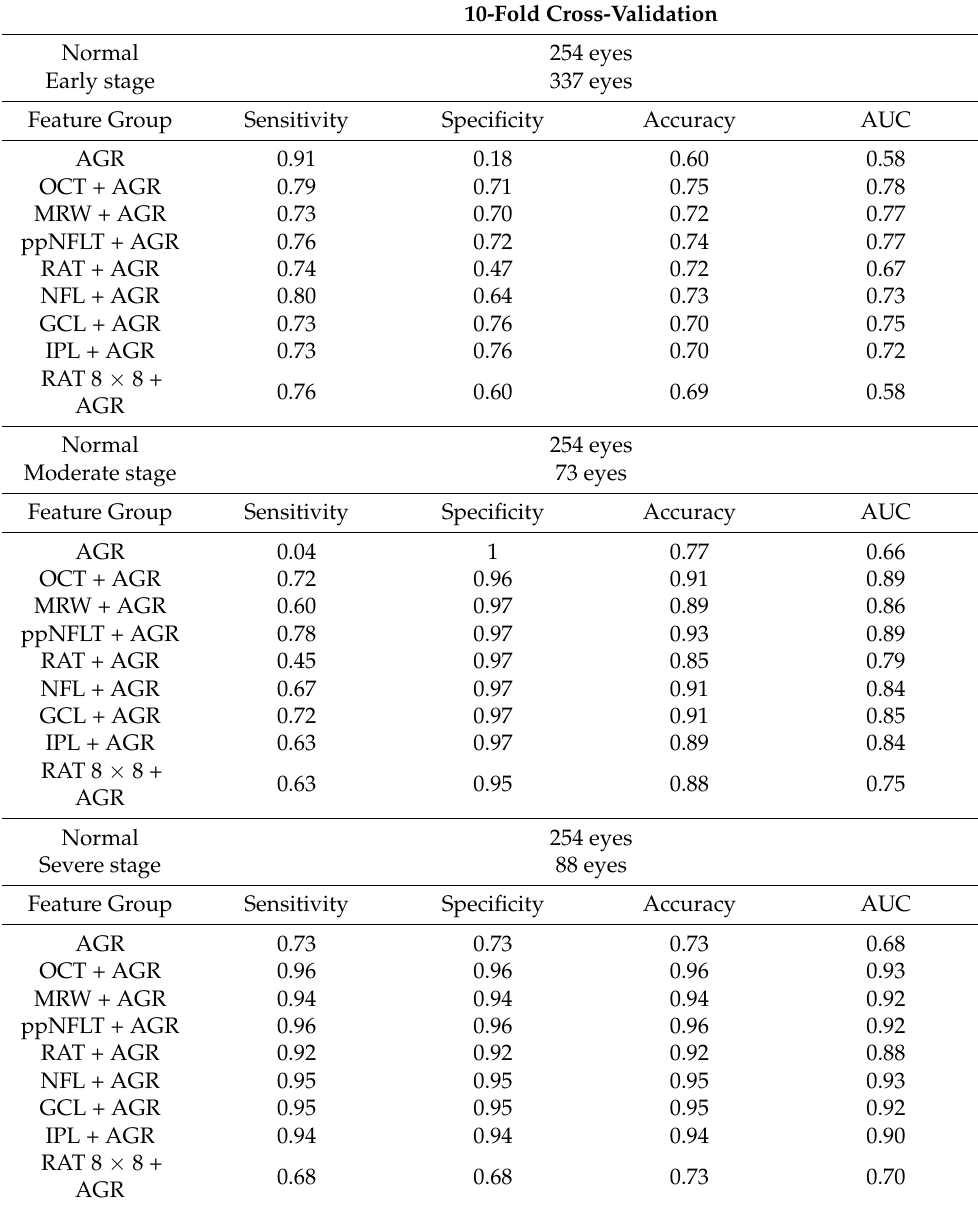
Table 6. SVM classification results between normal and different stage of glaucomatous eyes using each OCT-related feature groups (plus age, gender, and